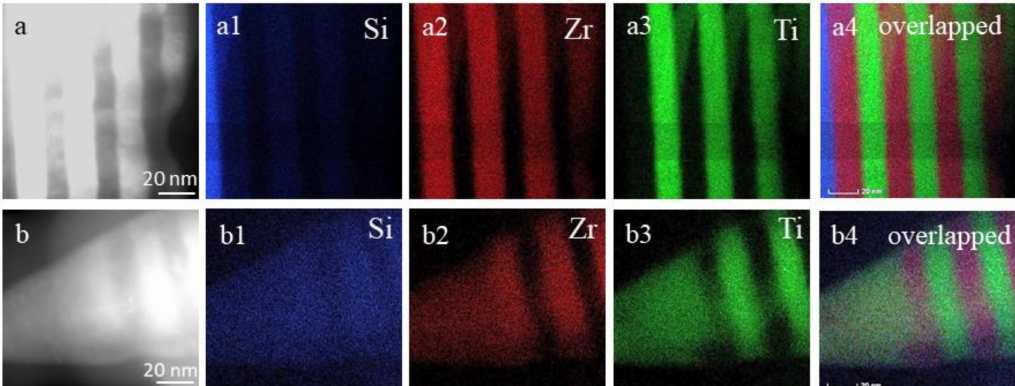
Figure 6. Elemental mapping (Si, Zr, and Ti) and their overlapping for ( a ) an as-deposited, ( a1 ) elemental map for Si, ( a2 ) elemental map for Zr, ( a3 ) elemental map for Ti, ( a4 ) overlapped all elemental map and ( b ) laser-modified 15 × (Ti / Zr) / Si multilayer thin film, ( b1 ) elemental map for Si, ( b2 ) elemental map for Zr, ( b3 ) elemental map for Ti, ( b4 ) overlapped all elemental map